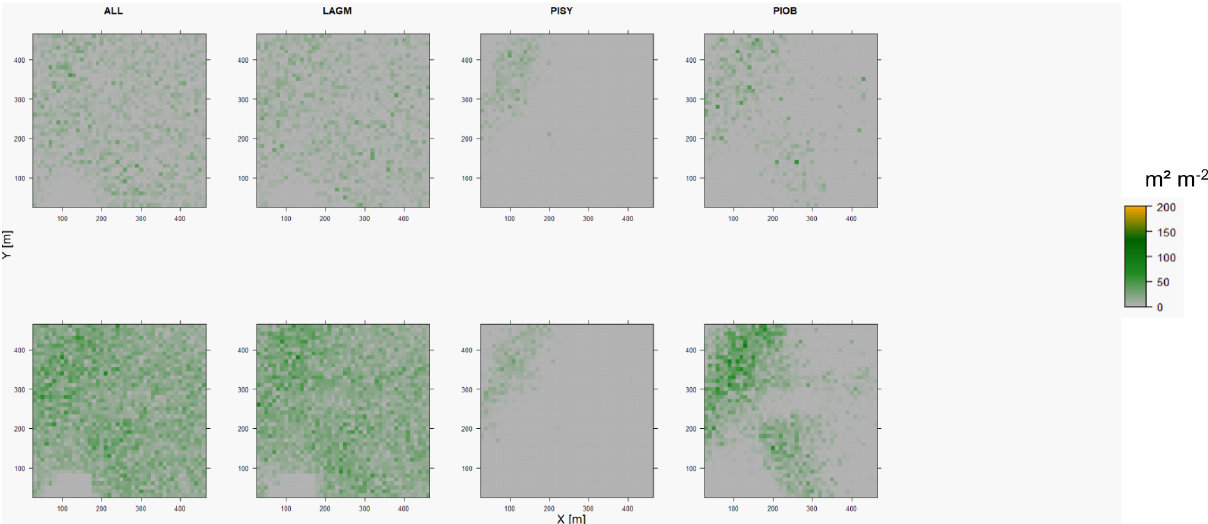
Figure D7. Leaf area index (LAI) values of the CryoGrid grid aggregated at year 2025 at Nyurba. Upper row shows LAVESI–CryoGrid coupled; lower row shows LAVESI simulations. LAGM: Larix gmelinii ; PIOB: Picea obovata ; PISI: Pinus sibirica ; PISY: Pinus sylvestris . Simulations with PISI were not possible.